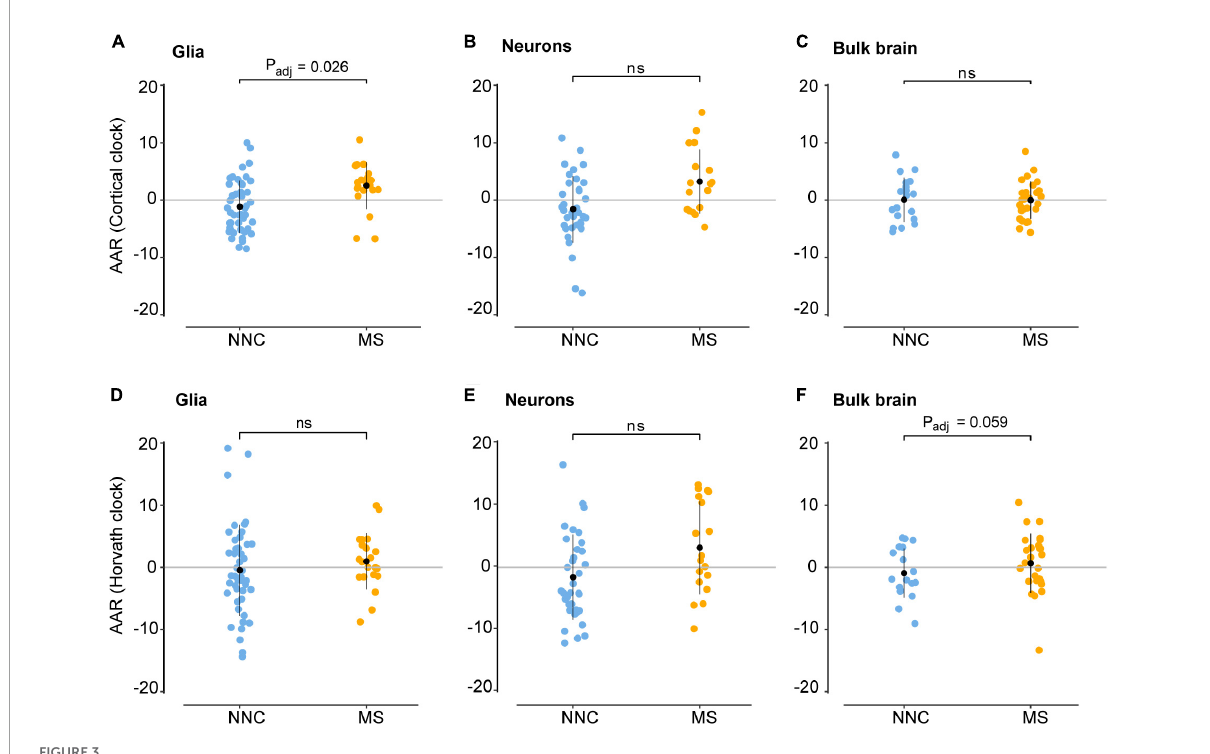
FIGURE3 Age acceleration in glial cells, neurons, and bulk brain of MS patients and controls. Age acceleration residuals (AAR) in glial cells [left panels (A,D) ], neurons [middle panels (B,E) ], and bulk brain tissue [right panels (C,F) ] of MS patients and controls were estimated using the Cortical clock (upper panels) and Horvath’s clock (lower panels). Normality was tested with the Shapiro–Wilk test. Equal variances were tested with Bartlett’s test. Sample means were compared with a two-sided two-sample t -test. In case of unequal variances (D) , Welch’s t -test was performed instead. Significance refers to covariate-adjusted P-values, with P adj < 0.05 considered significant (for unadjusted P-values, see Table 3 ). Adjustment refers to sex, PMI, replicate status, PC1 (dataset of origin) in glia; sex, PMI, and replicate status in neurons; and sex, PMI, and neuronal cell proportions in the bulk brain. Data were retrieved from Huynh et al. (2014), Kozlenkov et al. (2014), Gasparoni et al. (2018), and Kular et al. (2019, 2022). MS, multiple sclerosis; NNC, non-neurological controls; ns, not